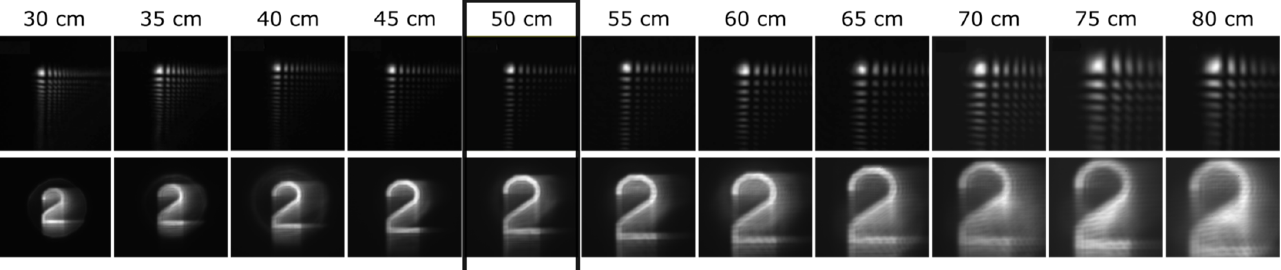
Figure 6. Numerical simulation of the PSFs (top) and the images of the extended object (bottom) for the combined APM + FL imaging system with the optimized value 𝛼 = 100 𝜋⁄ along the z’-image plane range (rectangle in the in-focus position). The pupil size was L = 8.64 mm.